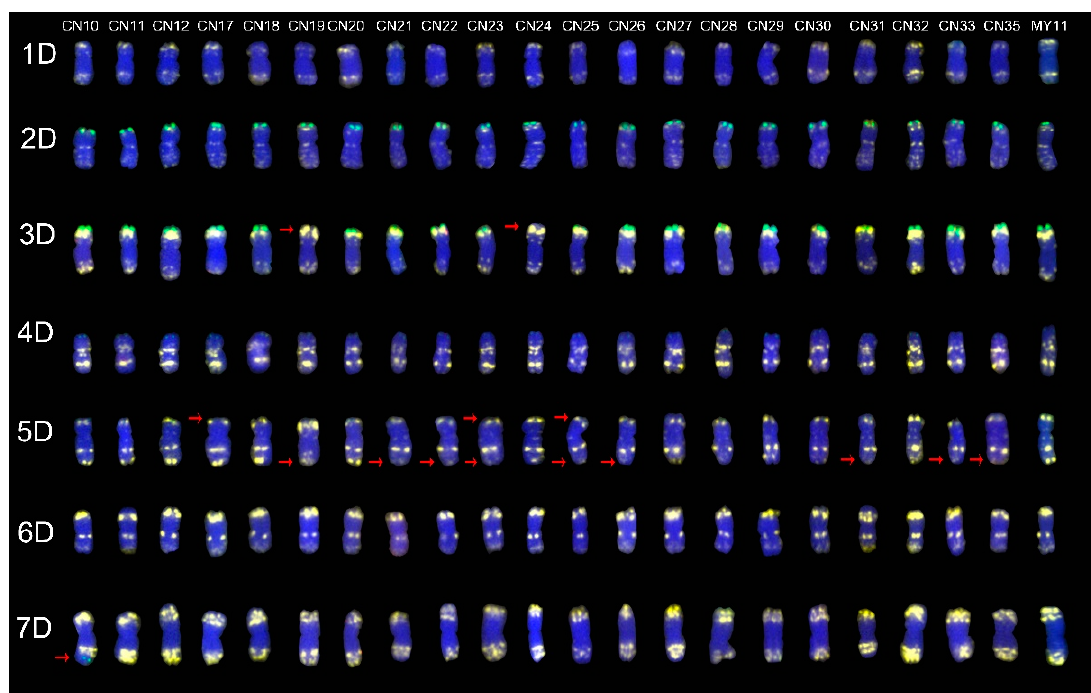
Figure 3. The ND-FISH results of D-genome chromosomes of all materials. From left to right: CN10, CN11, CN12, CN17, CN18, CN19, CN20, CN21, CN22, CN23, CN24, CN25, CN26, CN27, CN28, CN29, CN30, CN31, CN32, CN33 and CN35, respectively. From top to bottom: 1D, 2D, 3D, 4D, 5D, 6D and 7D chromosome, respectively. The red arrows showed the mutant signal patterns on chromosomes. Yellow: Oligo-pTa535-1; Green: Oligo-pSc119.2-1; Red: Oligo-Ku, Oligo-pSc200 and Oligo-pSc250.Blue: DAPI.